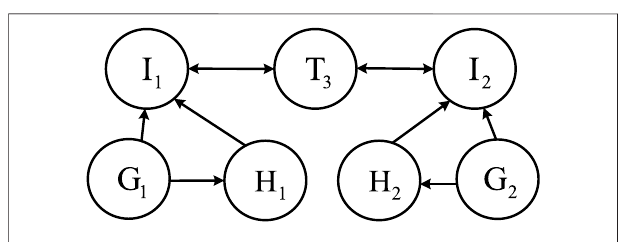
FIGURE 3 | Failure directed graph of the photovoltaic power generation